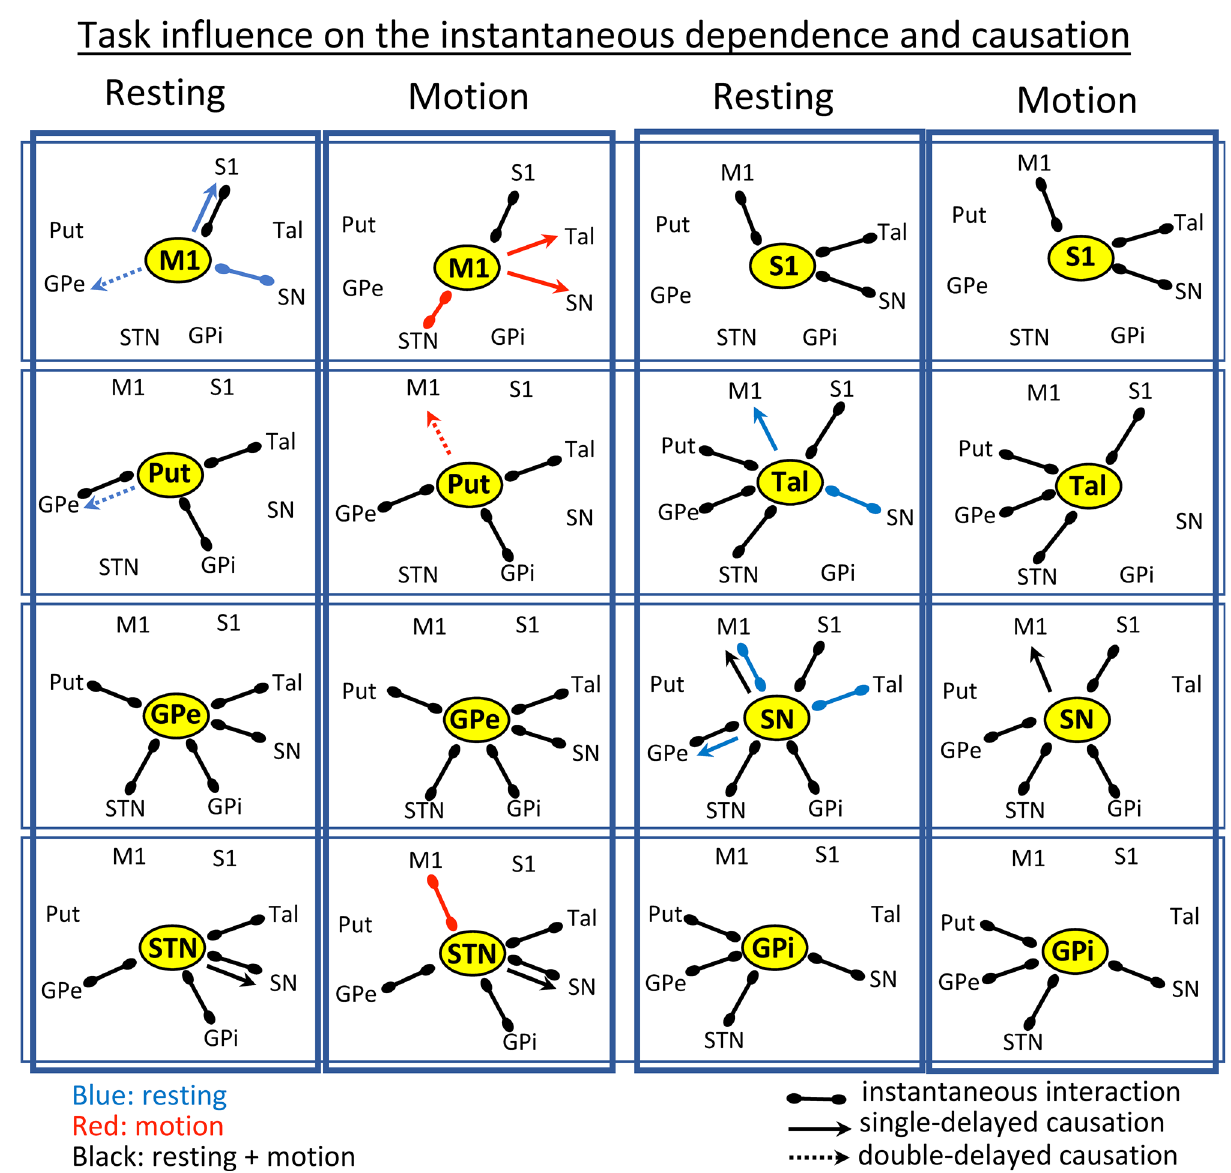
Figure 3. Influence of tasks on the functional interactions of BG. Connections between centers show relationships with statistical value ( p < 0.01). Blue lines show the statistical interactions only observed during the resting task. Red lines show the statistical interactions only observed during the motor task. Black lines show the statistical interactions observed during both resting and motor tasks. M1: primary motor cortex, S1: primary somato-sensory cortex, Put: putamen, GPe: external globus pallidum, STN: subthalamic nucleus, GPi: internal globus pallidum, SN: substantia nigra, Tal: motor